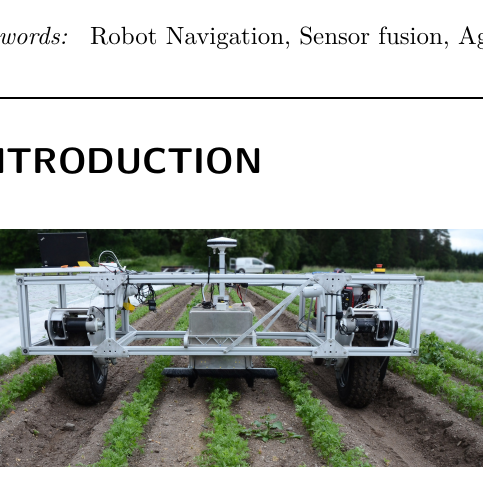
Figure 1: A prototype of the Asterix